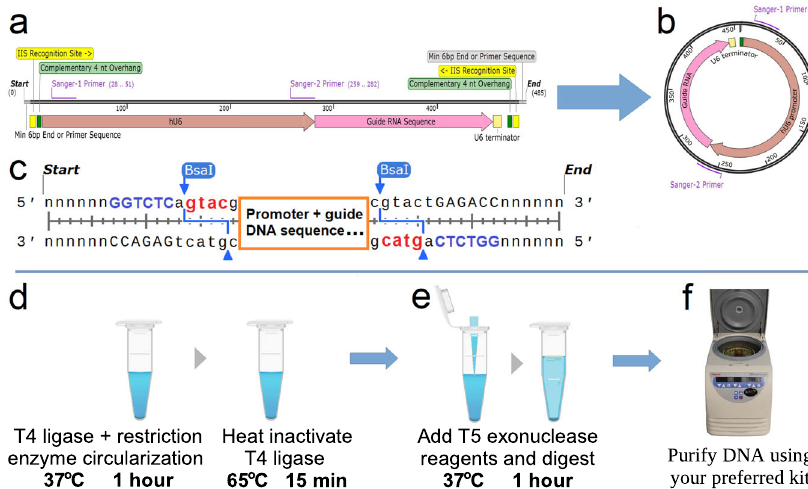
Fig. 1 Circularization of dsDNA containing an expression element and the circularization protocol steps. a Expression element containing type IIS restriction enzyme recognition sites with complementary overhangs on both ends of the DNA fragment. b Cuts by the restriction enzyme and ligation of the resulting overhangs form the circular DNA expression element. T5 exonuclease is used to digest all non-circularized DNA. c Schematic view of complementary 4nt overhangs ( gtac ) created by restriction enzyme cuts (BsaI GGTCTC ), see Supplementary Fig. 1 for a detailed example of prime editing epegRNA coding. Protocol steps: ( d ) Pipette dsDNA template with T4 DNA ligase and type IIS restriction enzyme reagents, then program incubation at 37 o C for 1 h (or longer, if desired), followed by the heat activation of T4 DNA ligase at 65 o C for 15 min. If left unattended, set the program cycler to pause at 4 o C. e Add an equal volume of T5 exonuclease reagents to the same tube and digest at 37 o C for 1 h. f Purify the circularized DNA expression construct from the reaction mix using a DNA cleanup kit.